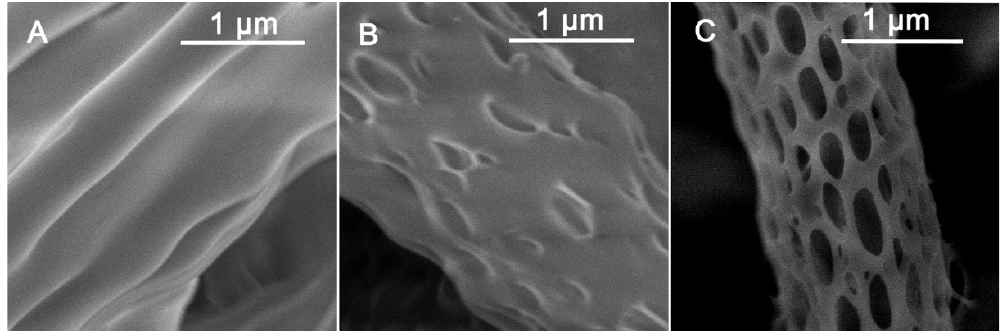
Figure 2. SEM of PDLLA fibers electrospun with different temperature under 80% humidity, ( A ) 15 °C; ( B ) 20 °C; ( C ) 25 °C.